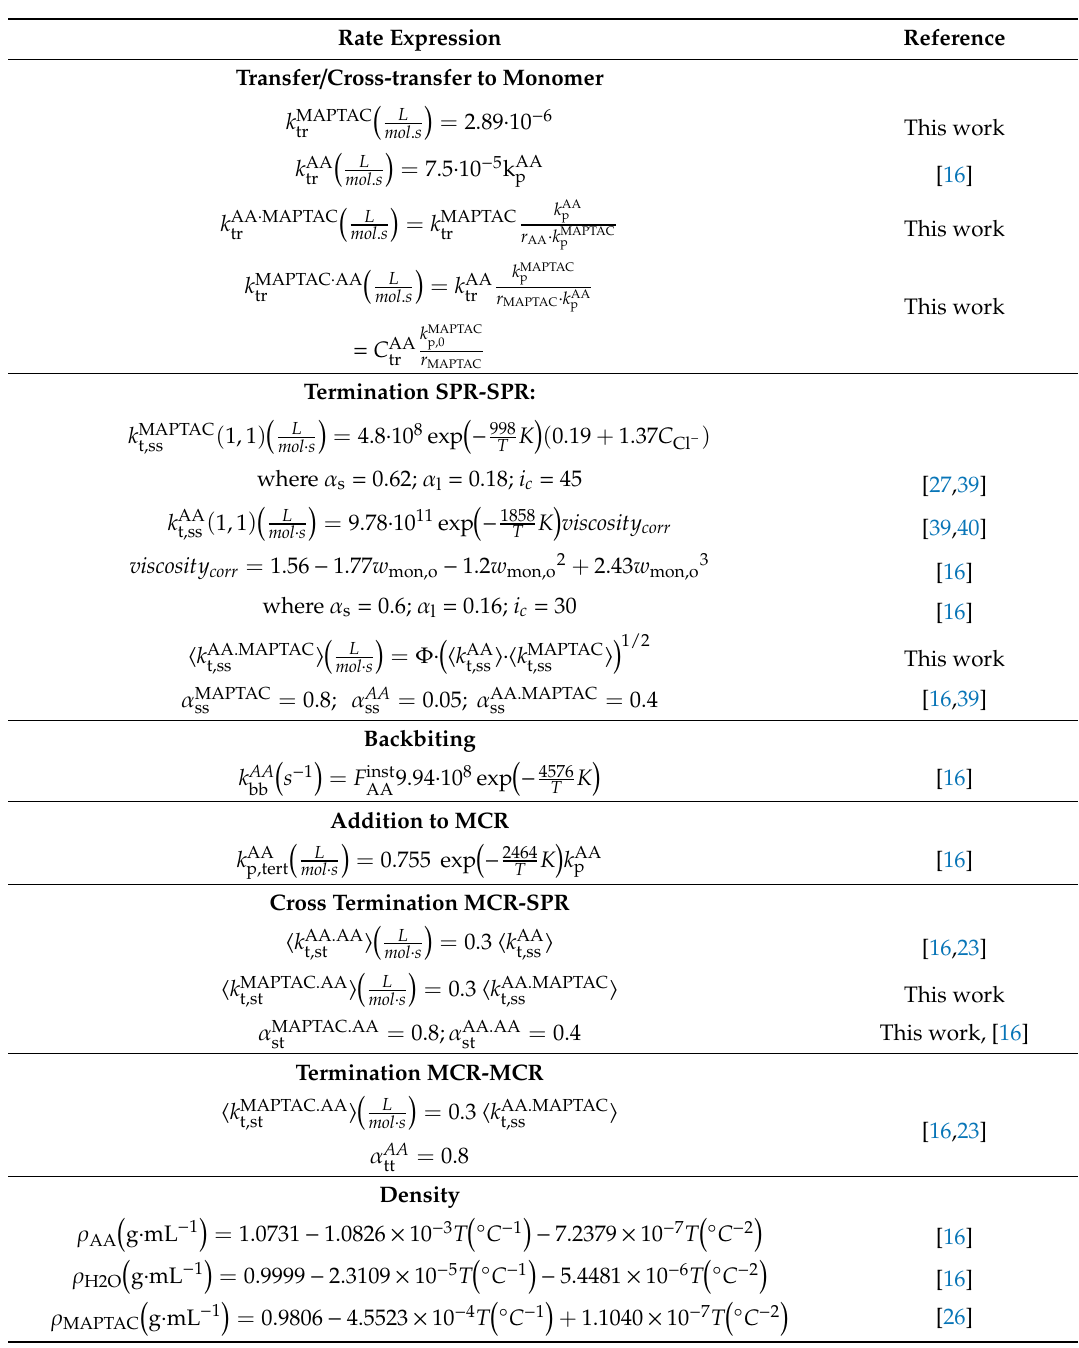
Table 2. Cont. Rate Expression